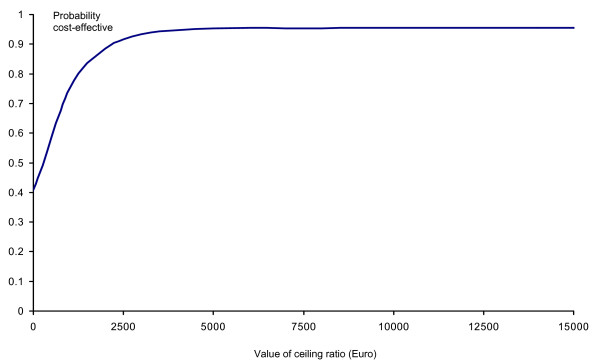
Acceptability curve for surgery vs. splinting for number of nights awake due to symptoms. At a ceiling ratio of EURO 2500 per patient there is a 90% probability that surgery is cost-effective.